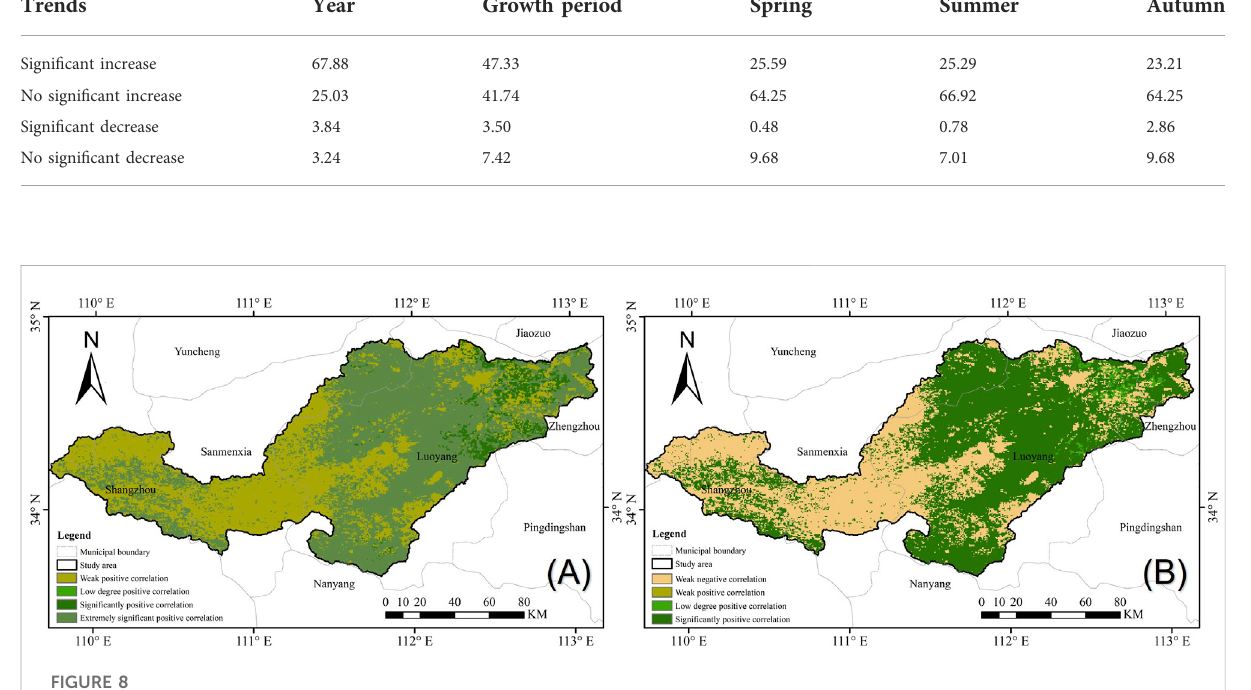
corresponding month. The spatial distribution of the correlation coef fi cient at different delay times is shown in Figure 9, and the area proportions of different correlation degrees in the basin are shown in Table 3 and Table 4. As previously mentioned, the correlation between NPP and climatic factors is strongest in the current month, followed by 1 month.